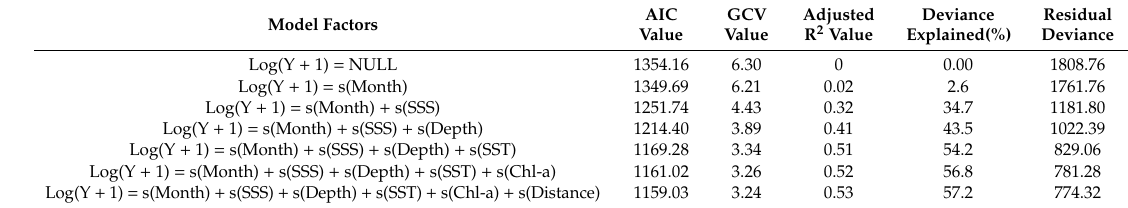
Table 1. Deviance analysis for the general additive models (GAMs) fitted to the fish-egg